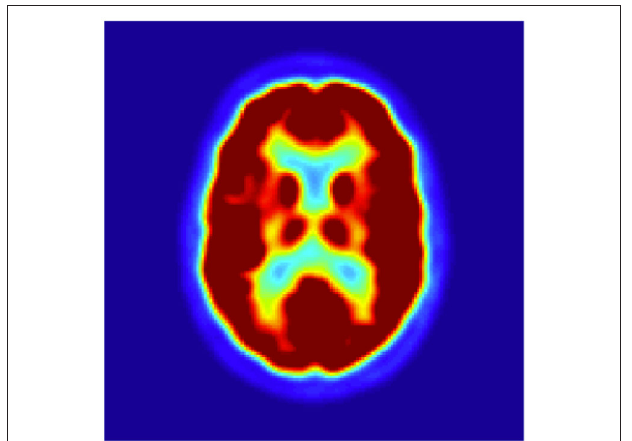
FIGURE 4 | Sample of preprocessed NC images.